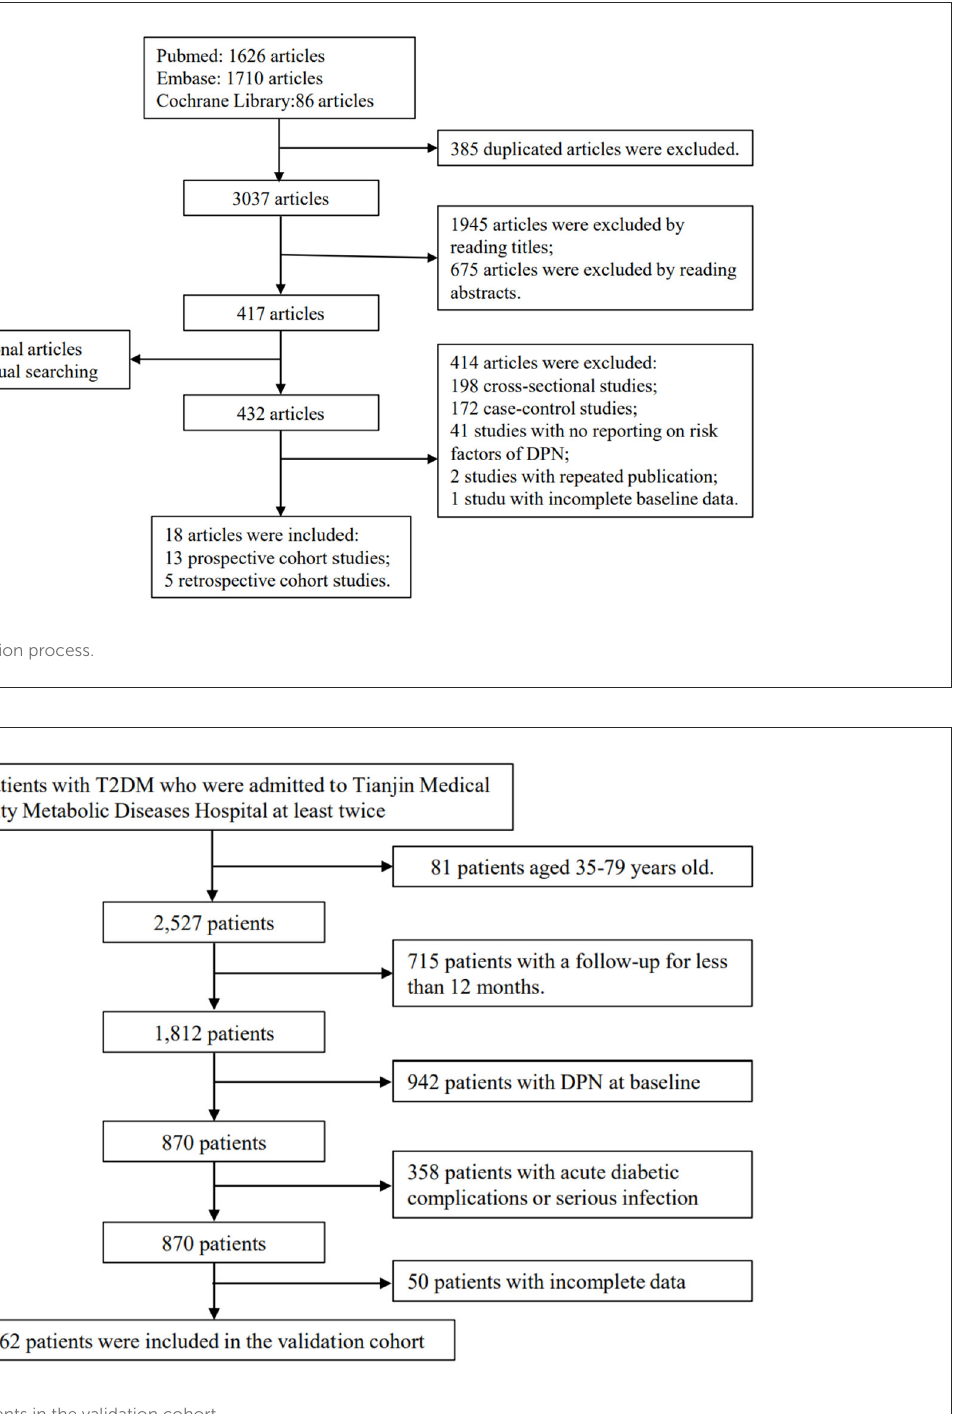
FIGURE2 Process for the selection of patients in the validation